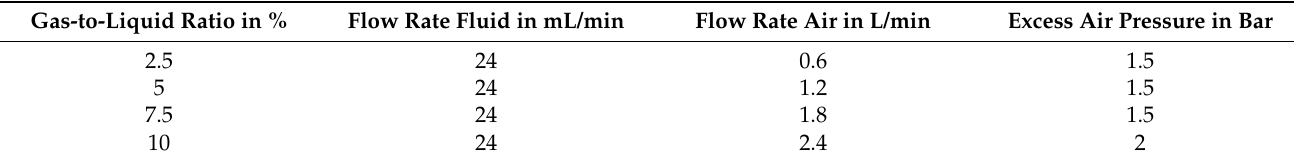
Table 2. Overview of investigated spray parameter